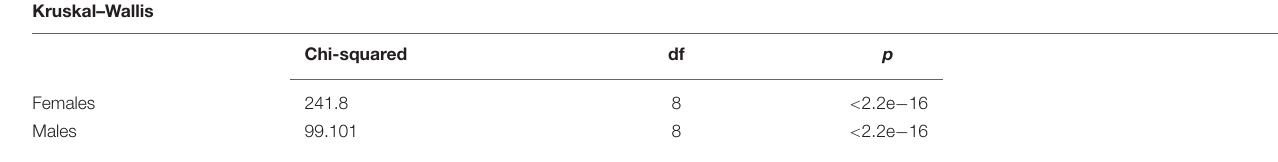
TABLE 1 | Results of statistical results from RELSA max